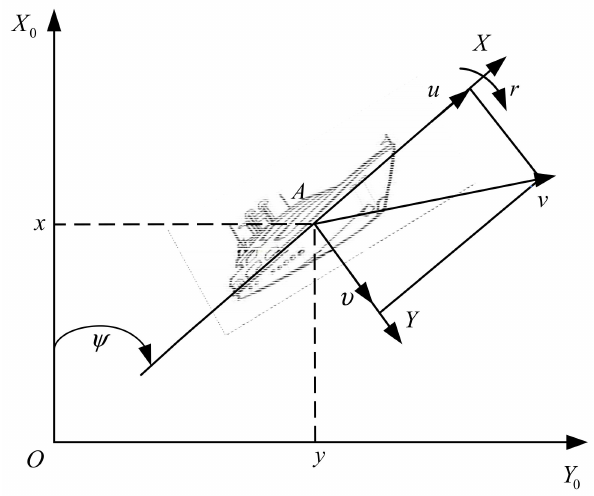
Figure 1. The ship’s motion coordinate